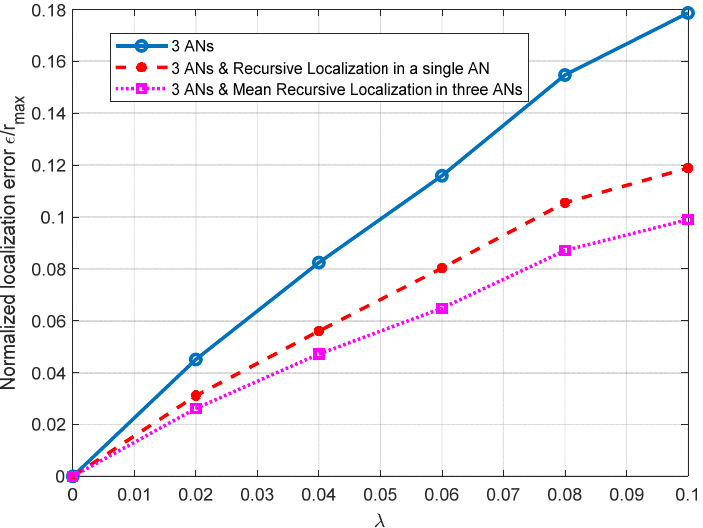
Figure 4. Normalized mean squared error ε / r max vs. exponentially distributed with parameter λ , considering three ANs, single and mean RL for three ANs and r max = 10 m.